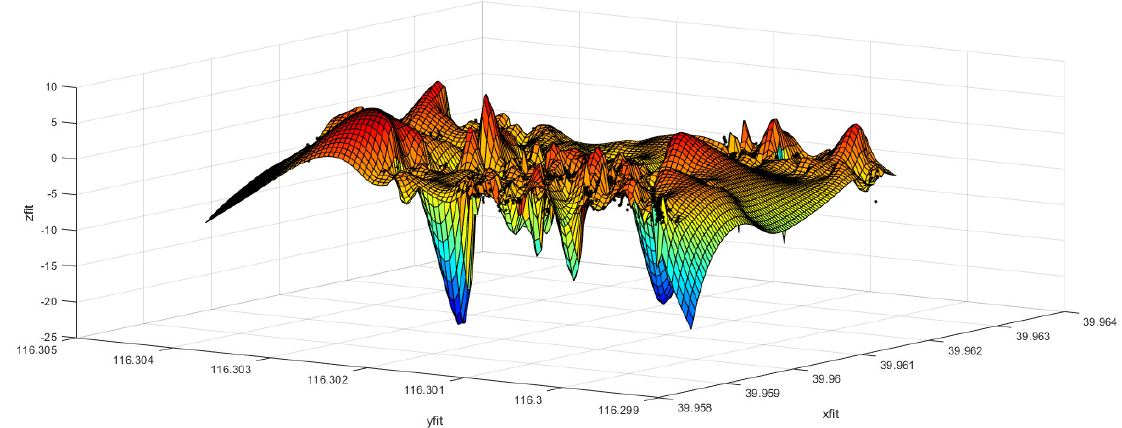
Remote Sens. 2021 , 13 , x FOR PEER REVIEW Figure 8. Fitting result using Green’s function-based interpolation method. Figure 8. Fitting result using Green’s function-based interpolation method. Figure 8. Fitting result using Green’s function-based interpolation method.